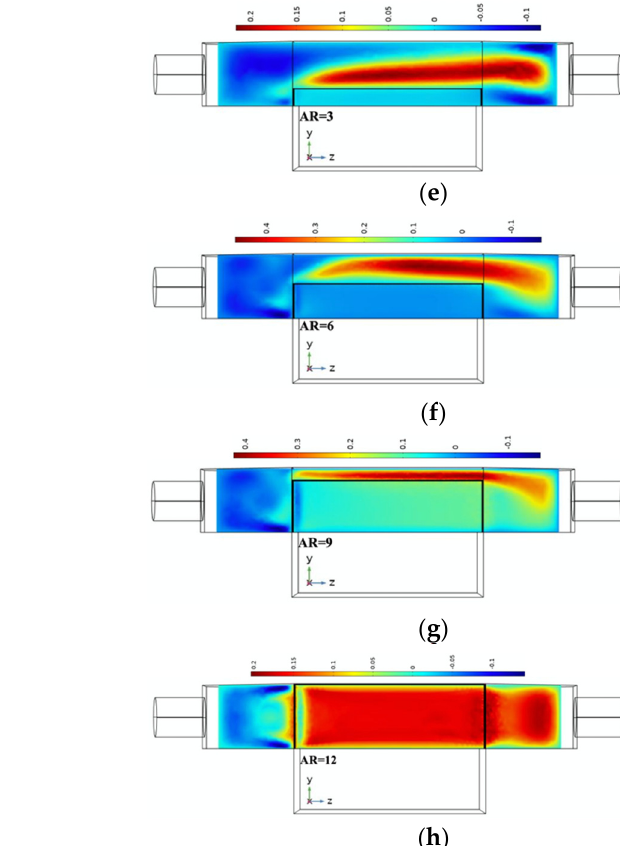
Figure 6. Flow distribution at the middle of the test section ( a – d ) and near the wall ( e – h ).